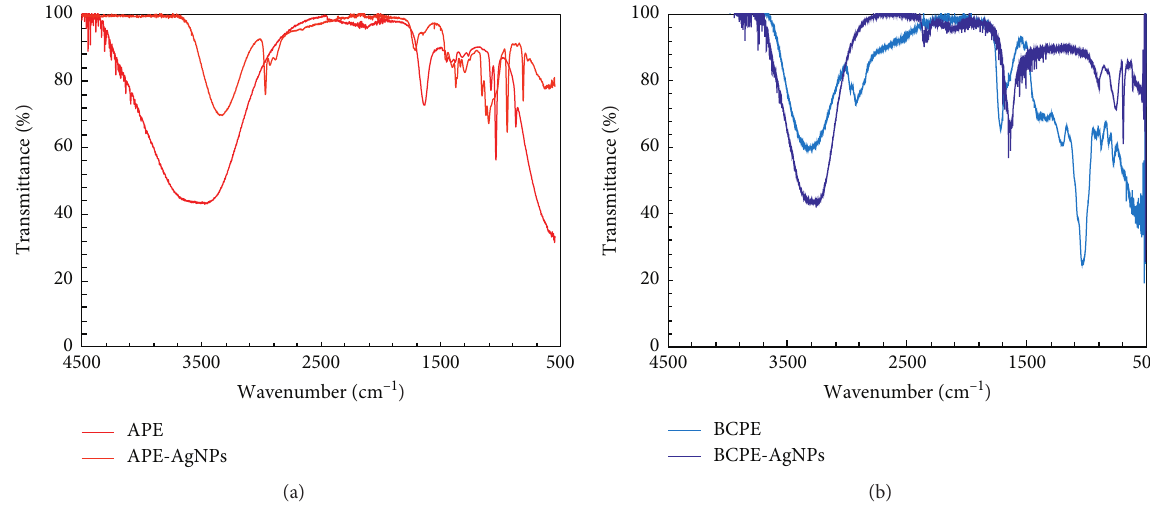
Figure 6: FT-IR spectra of the black currant and apricot pomace extracts, BCPE-AgNPs and APE-AgNPs.